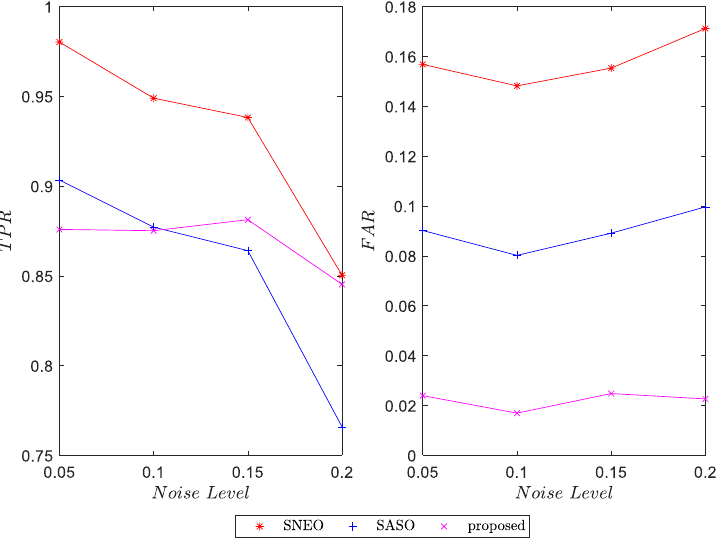
Figure 7. TPR and FAR on Difficult2 synthetic dataset over the four different noise levels: SNEO , SASO , and our proposal.